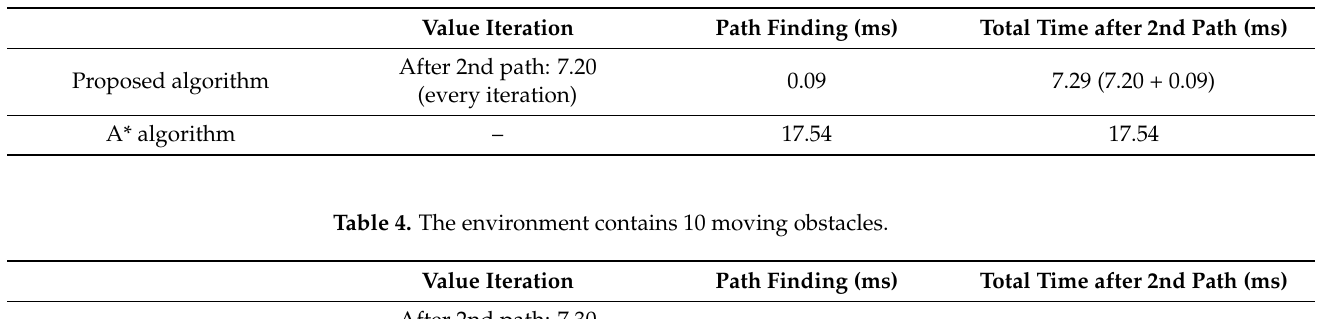
Table 3. The environment contains 5 moving obstacles.